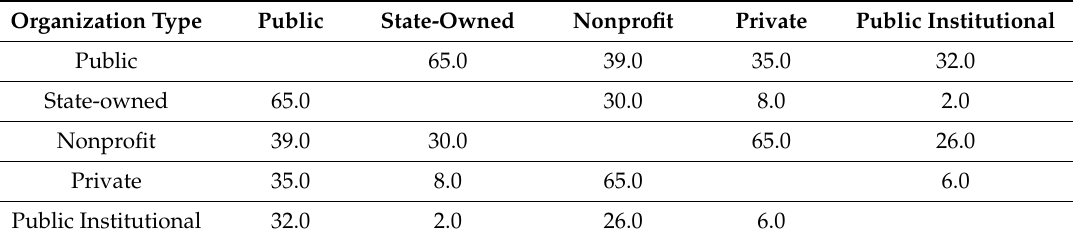
Table 1. Cross-border interaction between di ff erent types of organizations.